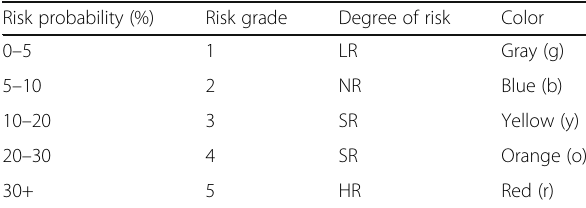
Table 2 The risk grade of the venture Risk probability (%)